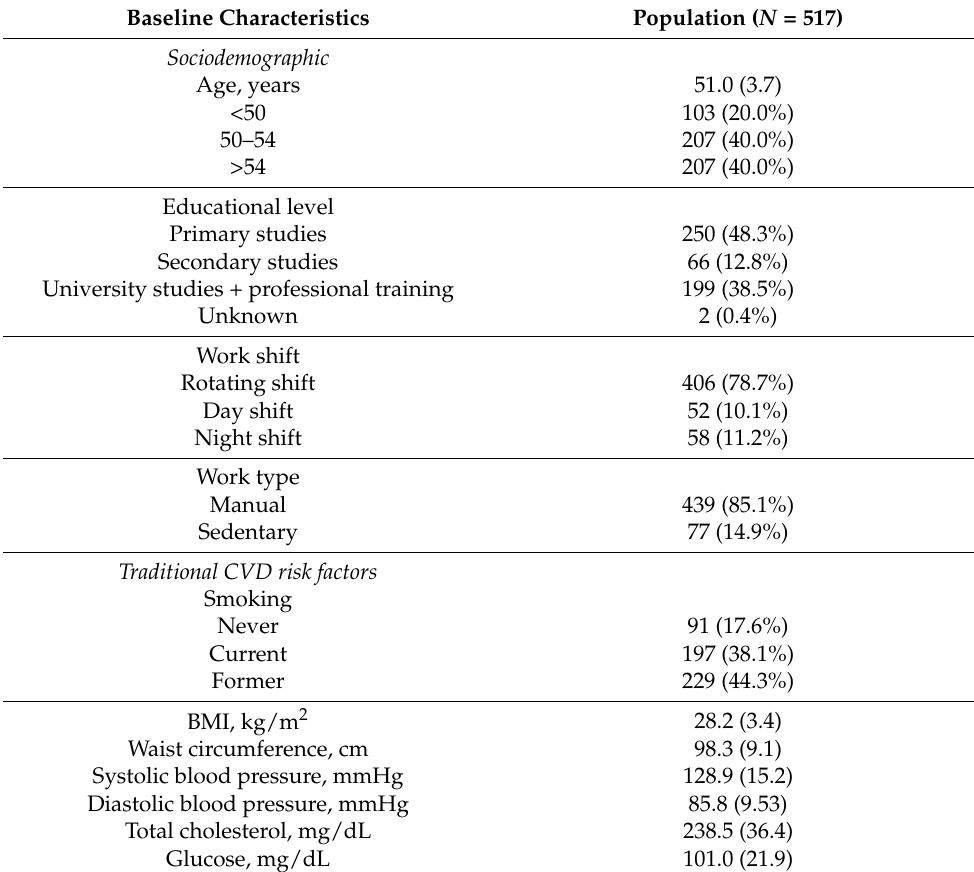
Table 1. Baseline characteristics of the study